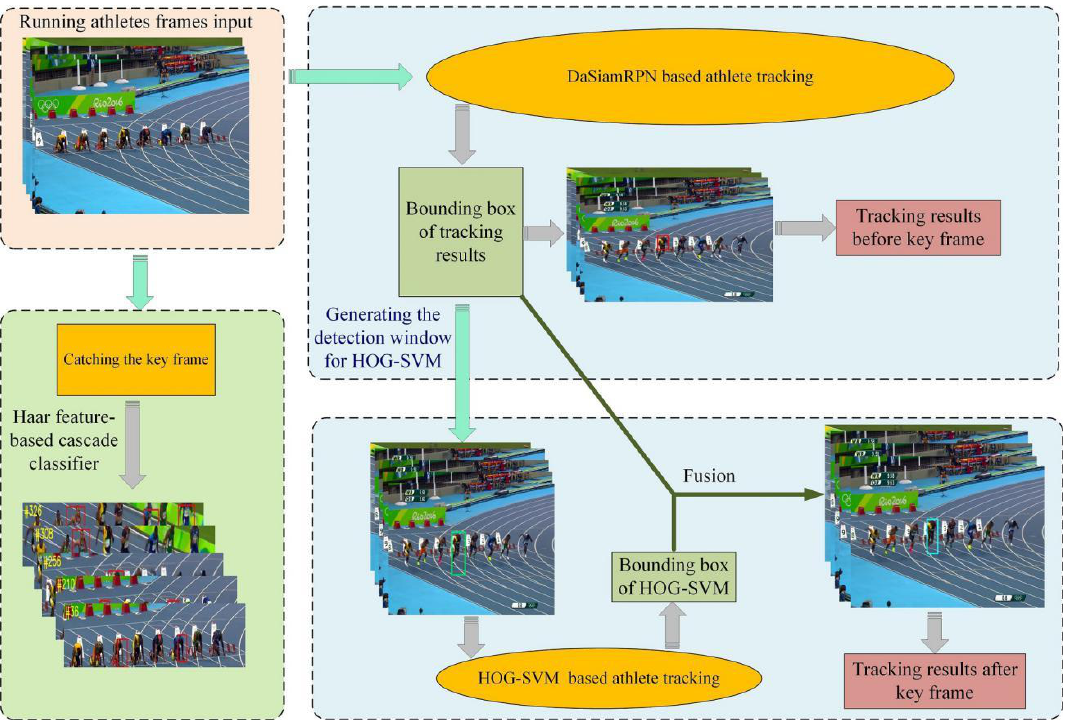
Figure 1. The architecture of proposed detection pipeline tracking combining the distractor-aware SiamRPN (DaSiamRPN) with Histograms of Oriented Gradients with a linear Support-Vector Machine (HOG-SVM).